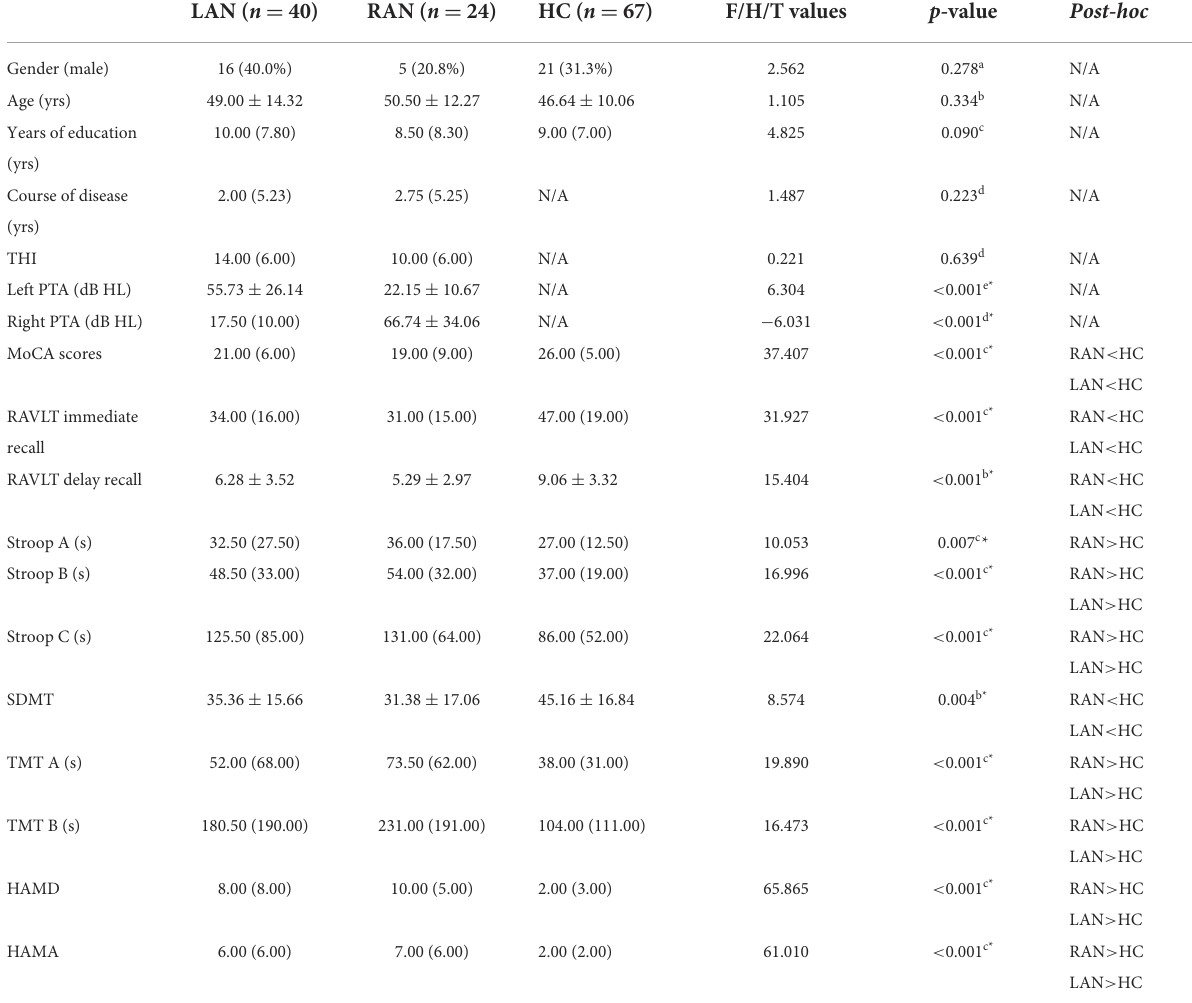
TABLE 1 Comparison of clinical data and cognitive function among LAN, RAN, and HC